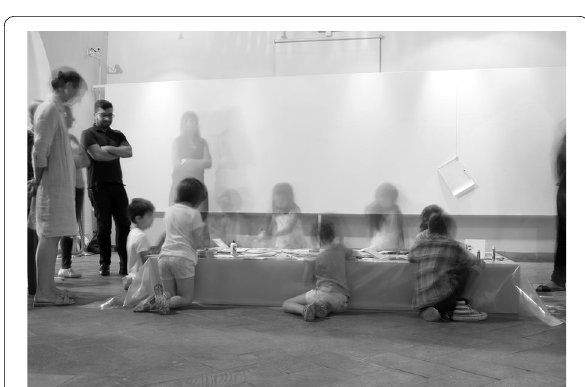
Fig. 6 Exhibition "Idee per una città accogliente", Palazzo della Frumentaria, 24 June—8 July 2016, Sassari. Photo: G.M.